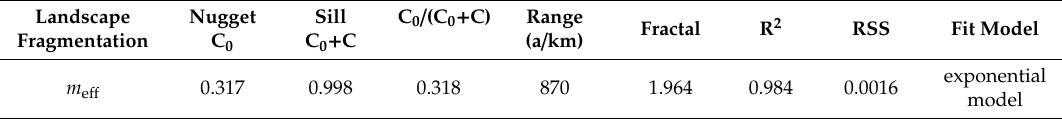
Table 2. Summary of model and structural components of the semi-variance functions for e ff ective mesh